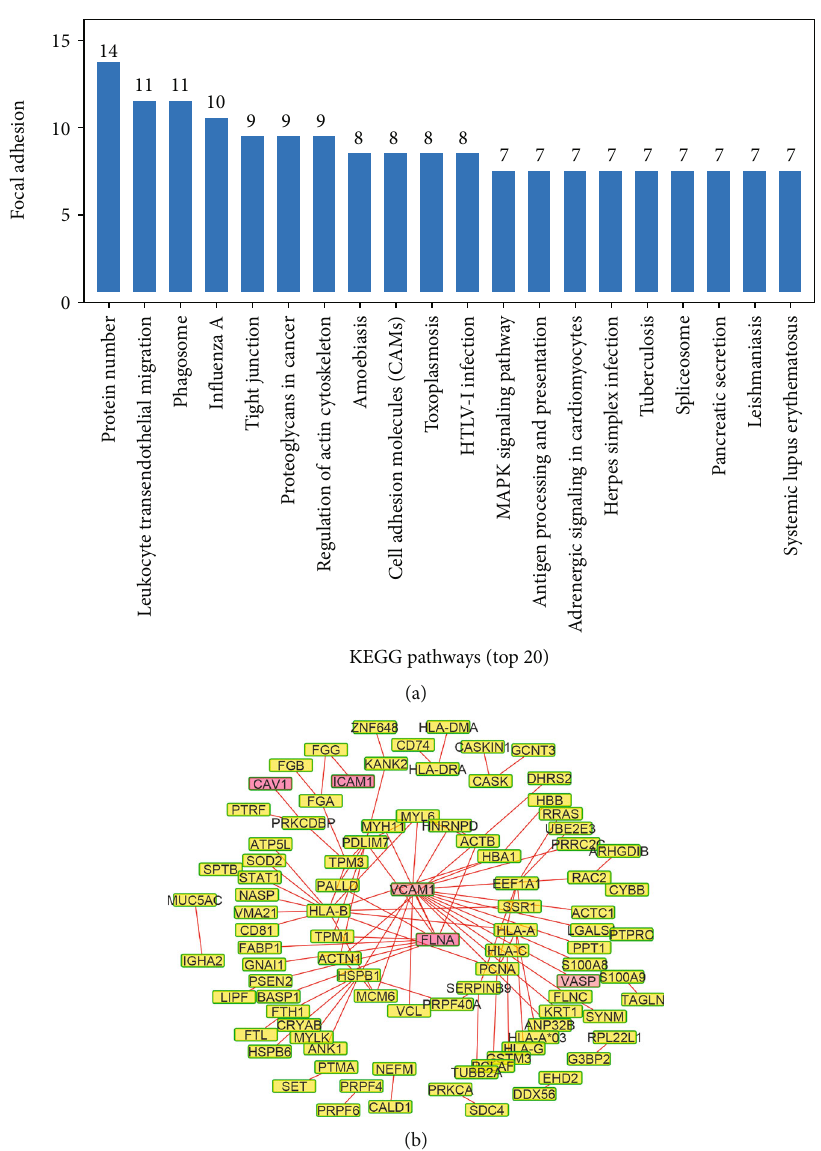
Figure 3: KEGG pathway and PPI analysis of the di ff erentially expressed proteins. (a) The top 20 KEGG pathways with di ff erentially expressed protein enrichment. (b) VCAM1 was located at the center of the PPI